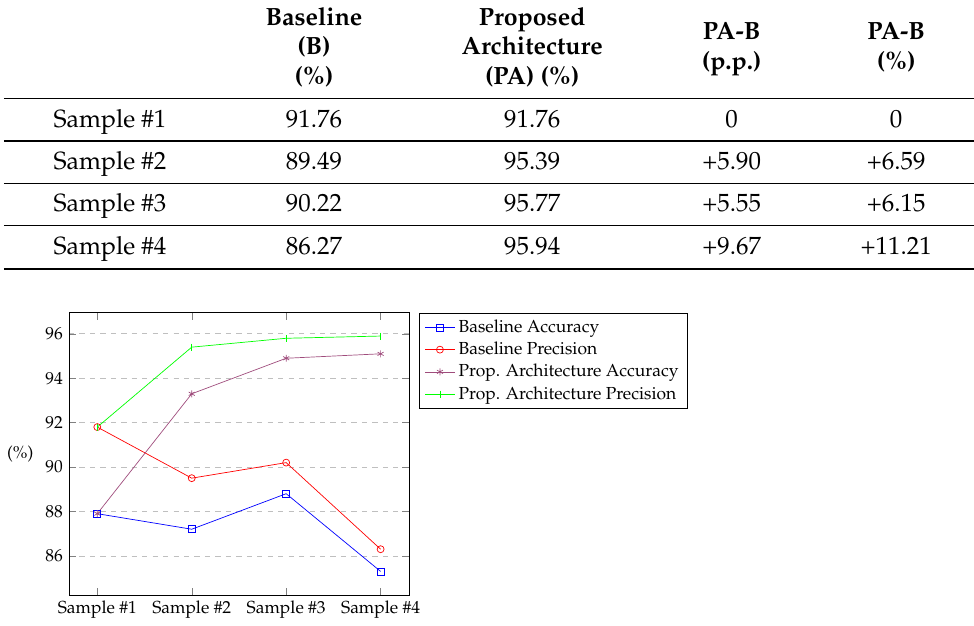
Figure 9. Results of accuracy and precision for the Baseline and the Proposed Architecture scenarios Fig. 9 draws the results of Table 7 and Table 8. From these results, it can be verified 316 that in the proposed architecture, as the model is always trained with a dataset that was 317 categorized with the contribution of several algorithms, both the accuracy and the precision 318 improve over the time. After four consecutive iterations in the proposed architecture, the 319 accuracy increased by 9.82 p.p. or 11.51%, and the precision increased by 9.67 p.p. or 320 11.21%, when compared to the baseline